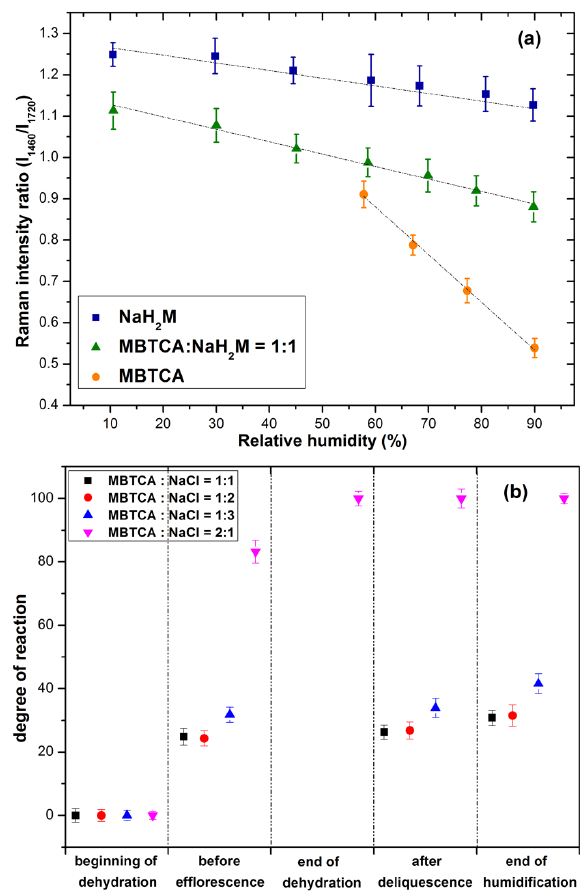
Figure 7. (a) Calibration curve calculated from the intensity ra- tios of two peaks at 1460 and 1720cm − 1 as a function of RH for NaH 2 M, MBTCA:NaH 2 M = 1:1, and MBTCA aerosols; (b) chemical reactivity represented as the degree of reaction for mixture aerosols of MBTCA:NaCl = 1:1, 1:2, 1:3, and 2:1 dur- ing the dehydration and humidification